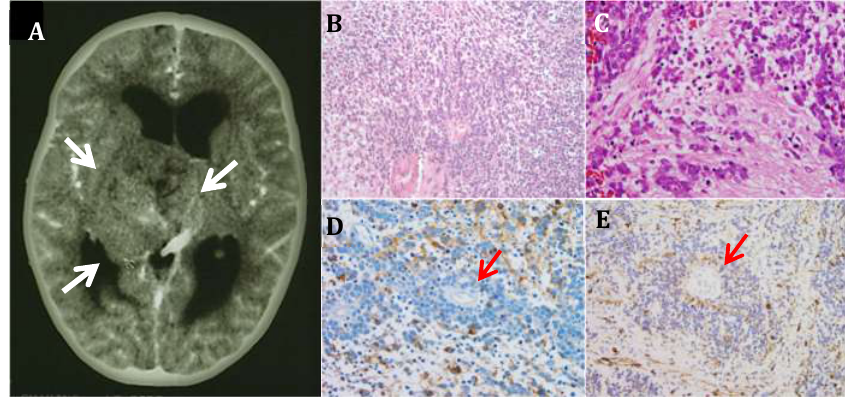
Figure 1. Primary CNS-Neuroblastoma. ( A ) Computerized Tomography image of a primary CNS-NB shows a large heterogeneous well-circumscribed lesion (arrows) measuring 5.7 × 5.2 × 4.8 cm, within the right thalamus (10×). ( B , C ). Histopathological examination shows islands of densely cellular poorly differentiated tumor cells, interspaced by sparsely cellular areas or finely fibrillary tissue. No mature neurons are identified (10× and 20× respectively). ( D ) Immunostain for neuron specific enolase (NSE) (20×); ( E ) Immunostain for synaptophysin (20×). Homer-Wright rosettes are frequent (red arrows).